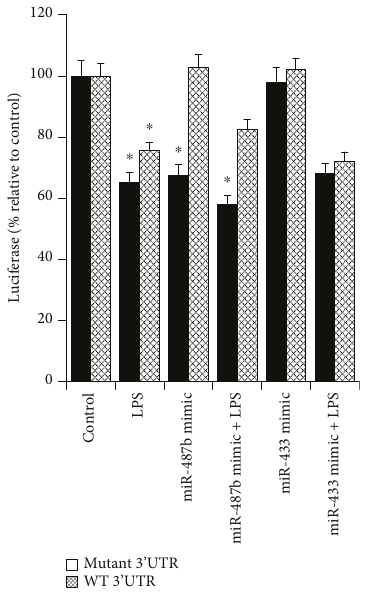
3’UTRMutant 3’UTR WT Figure 5: Analysis of the role of the miR-487b binding site in the 3 ′ UTR of the Kat6b mRNA. The Kat6b 3 ′ UTR was cloned downstream of the luciferase open reading frame in the pLightswitch-3 ′ UTR reporter plasmid (pKat6bLuc-3 ′ UTR). A second plasmid was prepared with the miR-487b binding site deleted (pKat6bLuc Δ 3 ′ UTR). RAW264.7 macrophages were transfected with either pKat6bLuc-3 ′ UTR or pKat6bLuc Δ 3 ′ UTR. Transfected cells were then treated with LPS for 6hr (100ng/ml) and analyzed for luciferase expression ( n = 3 ). RAW264.7 cells were also cotransfected with either pKat6bLuc-3 ′ UTR or pKat6bLuc Δ 3 ′ UTR together with either a synthetic miR-487b mimic or a nonspeci fi c miR mimic (miR-433). The cells were then treated with LPS (100ng/ml for 6 hr and analyzed for luciferase expression ( n = 3 ). Data represent the mean ± SE . ∗ indicates samples with luciferase expression signi fi cantly di ff erent from control luciferase expression ( p < 0 05